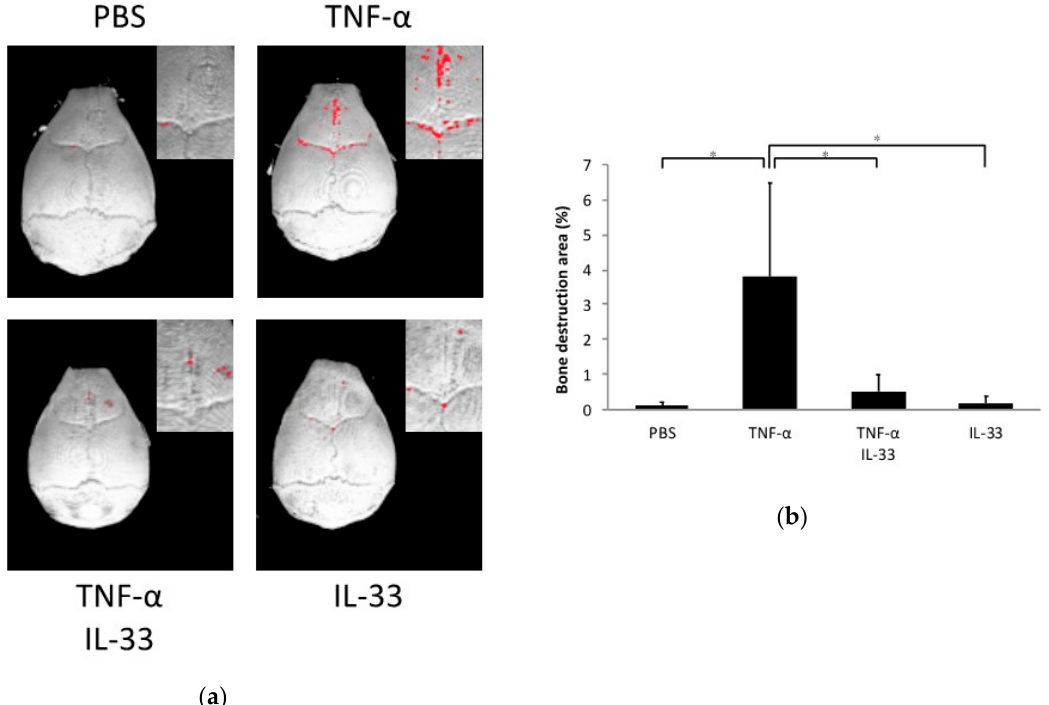
Figure 3. IL-33 inhibited TNF- α -induced bone resorption in vivo. ( a ) Three-dimensional images of mouse calvariae. After 5 days of daily supracalvarial injection of PBS, TNF- α , TNF- α + IL-33, or IL-33, calvariae were scanned by microfocus computed tomography (micro-CT). The red dots indicate bone destruction areas. ( b ) Ratio of the bone destruction area. Results are expressed as means ± SD. The statistical significance of differences was determined by Scheffe’s test ( n = 4; * p < 0.05).